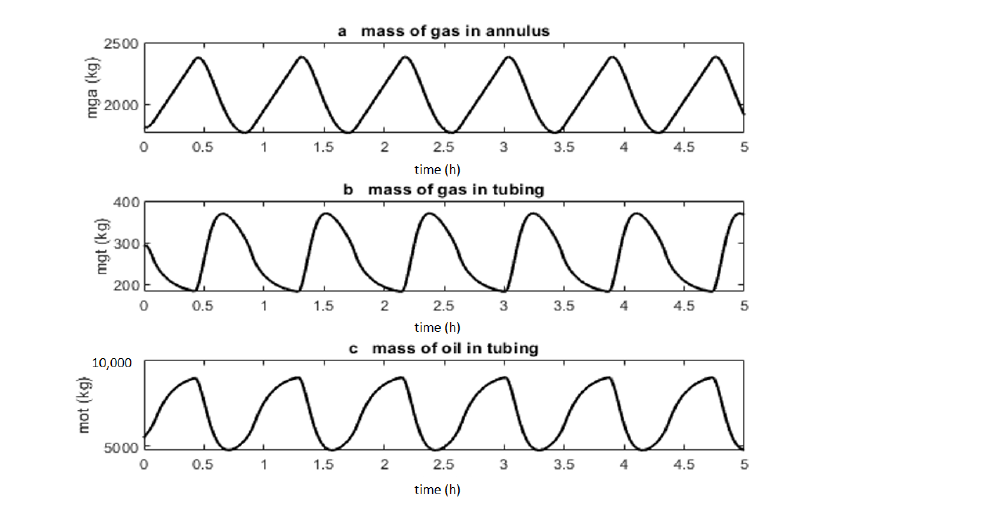
Figure 3. States of a gas-lifted system for u = 0.95 in an unstable mode. The states do not converge to fixed values but oscillate with a period of about 53 min. This oscillation is not healthy for the downstream equipment and it also reduces the mean oil